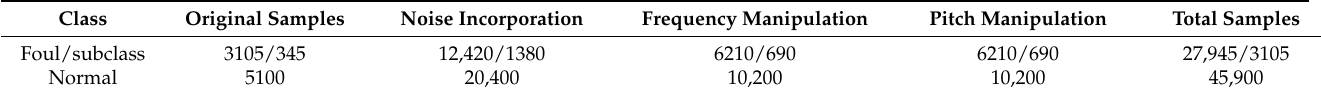
Table 2. Number of samples generated from different augmentation